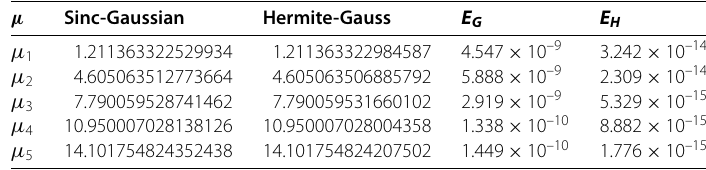
Table 1 Comparison of Hermite-Gauss and sinc-Gaussian, N = 7 and h = 1 μ Sinc-Gaussian Hermite-Gauss E G E H μ 1